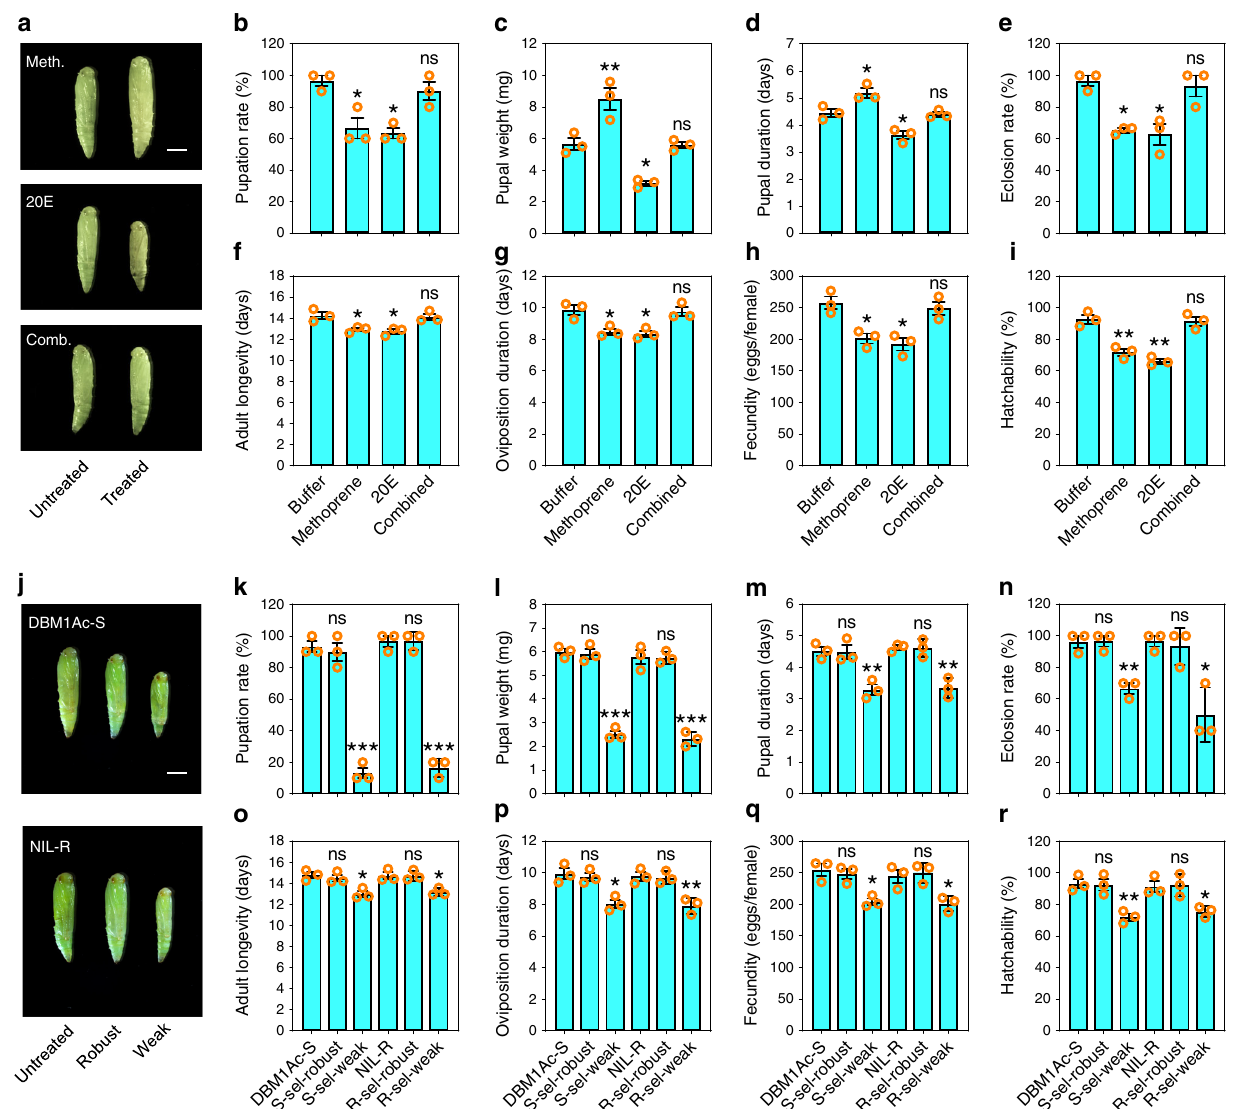
Fig. 7 The effect of hormone or Cry1Ac exposure on life-history traits in P. xylostella . a Representative pupal morphology after exogenous treatment (on day 0 of the third-instar larvae) with methoprene (upper box), 20E (middle box) or both (lower box). The scale bar is 1 mm. b – i Analysis of fi tness costs of exogenous hormone treatments. j Pupal morphology after exogenous treatment of third-instar larvae with an LC 50 dose of Cry1Ac protoxin for DBM1Ac-S (upper box) and NIL-R (lower box). The scale bar is 1 mm. k – r Analysis of fi tness costs of exogenous Cry1Ac treatments. Data are presented as mean values ± SEM, n = 3 biologically independent samples, * p < 0.05, ** p < 0.01, *** p < 0.001, ns, not signi fi cant, one-way ANOVA with Holm – Sidak ’ s test was used for comparison. Source data are provided as a Source Data fi